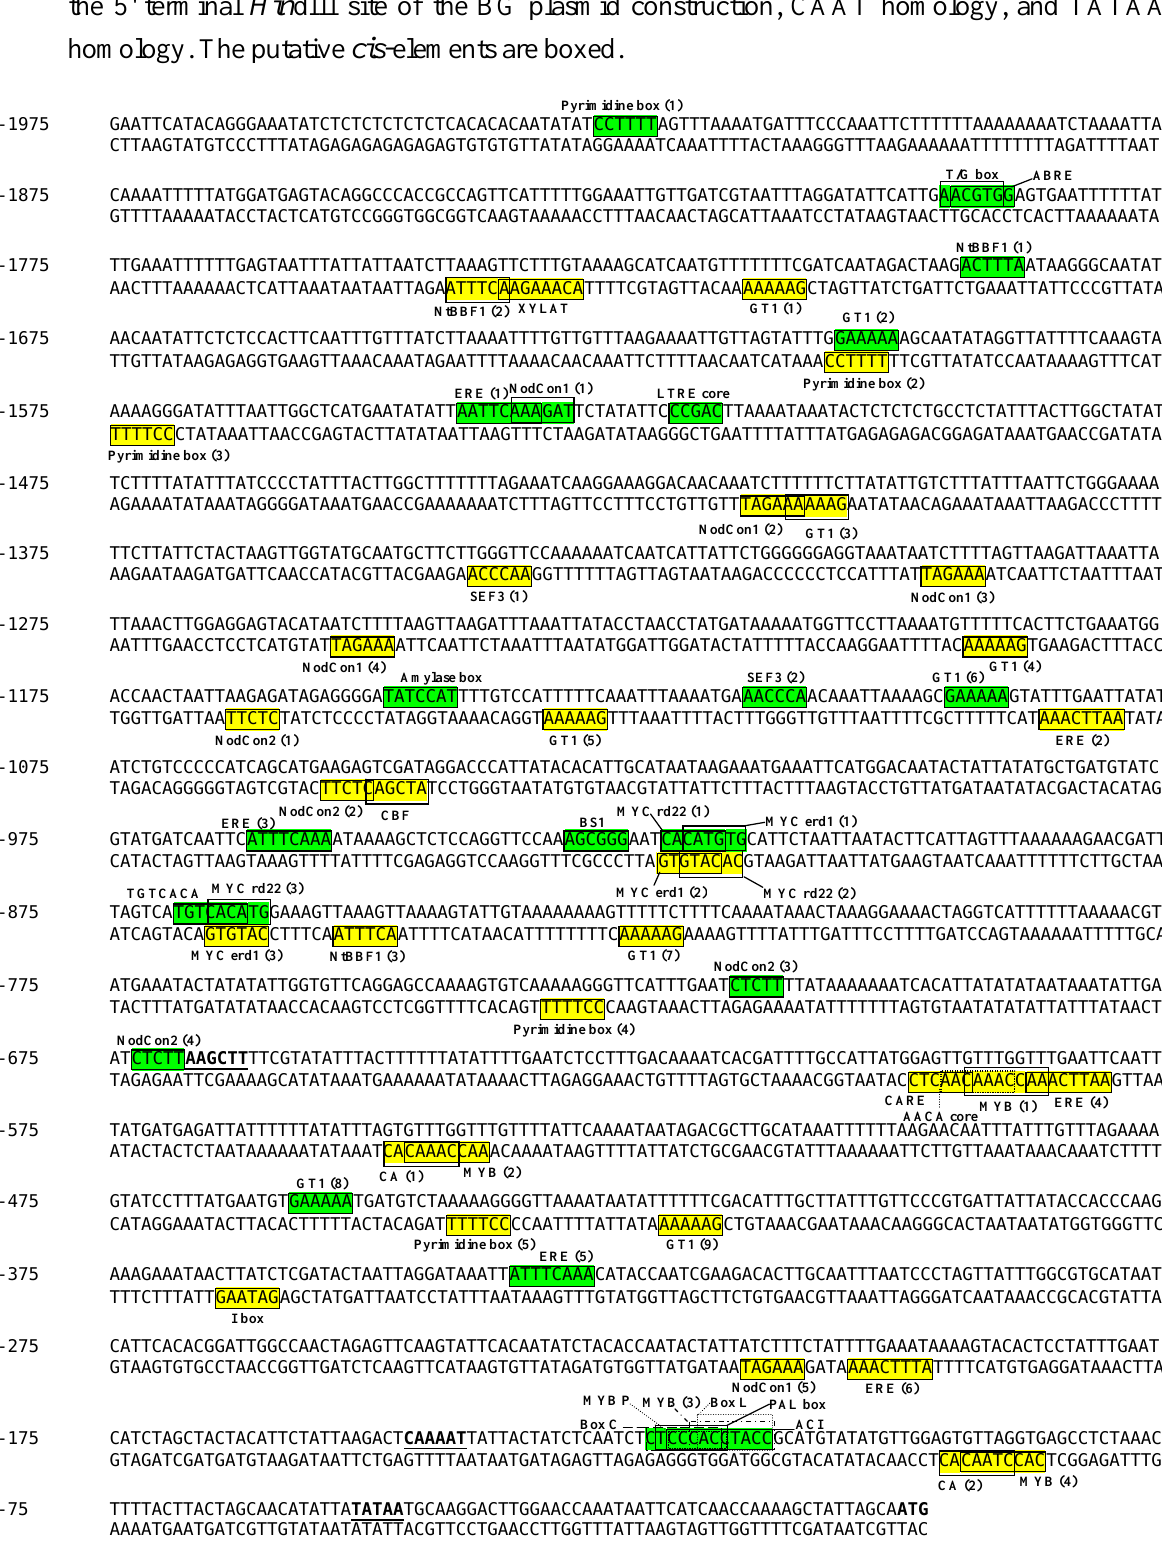
Figure 1. Sequenced region of the PPO B promoter showing putative cis -elements. PPO B bases are numbered starting with minus 1 as the first base 5' of the ATG translational start codon. The ATG start codon is in bold. The underlined bases, 5' to 3' respectively, represent the 5' terminal Hin dIII site of the BG plasmid construction, CAAT homology, and TATAA homology. The putative cis -elements are